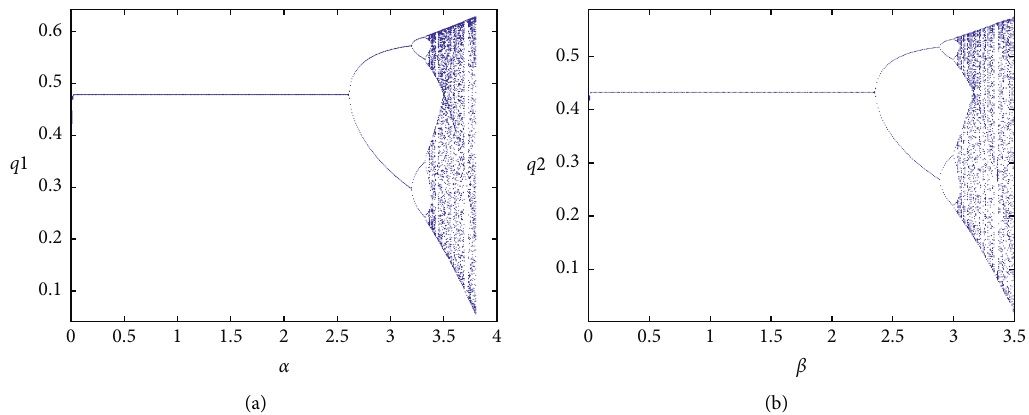
Figure 7: The bifurcation diagram of the model with respect to α and β .